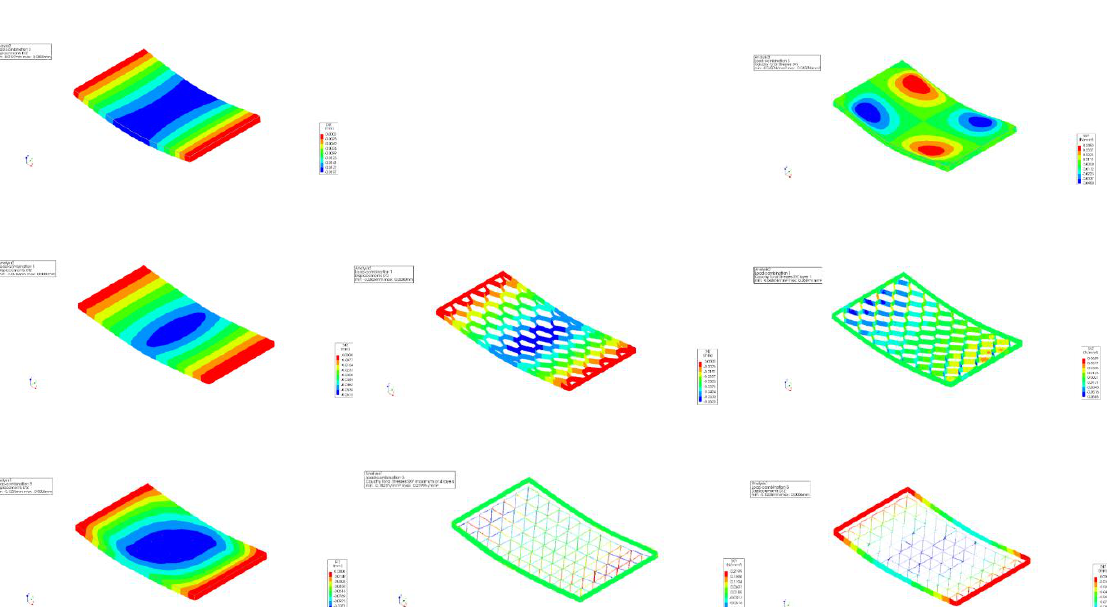
Fig. 6 Overview of the output of the FEM analysis (deflection panel(left), deflection core(middle) and shear stresses in the core(right)) of the three composite panels with the following cores: homogenous, honeycomb and